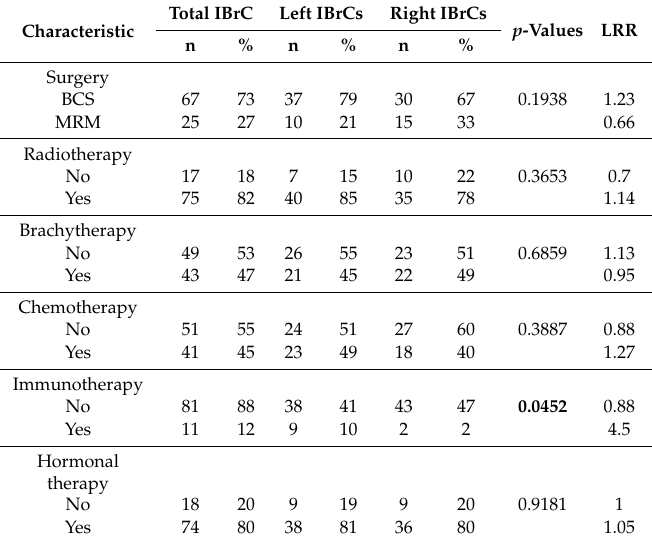
Table 2. Laterality of breast cancer patients and their treatment profiles.